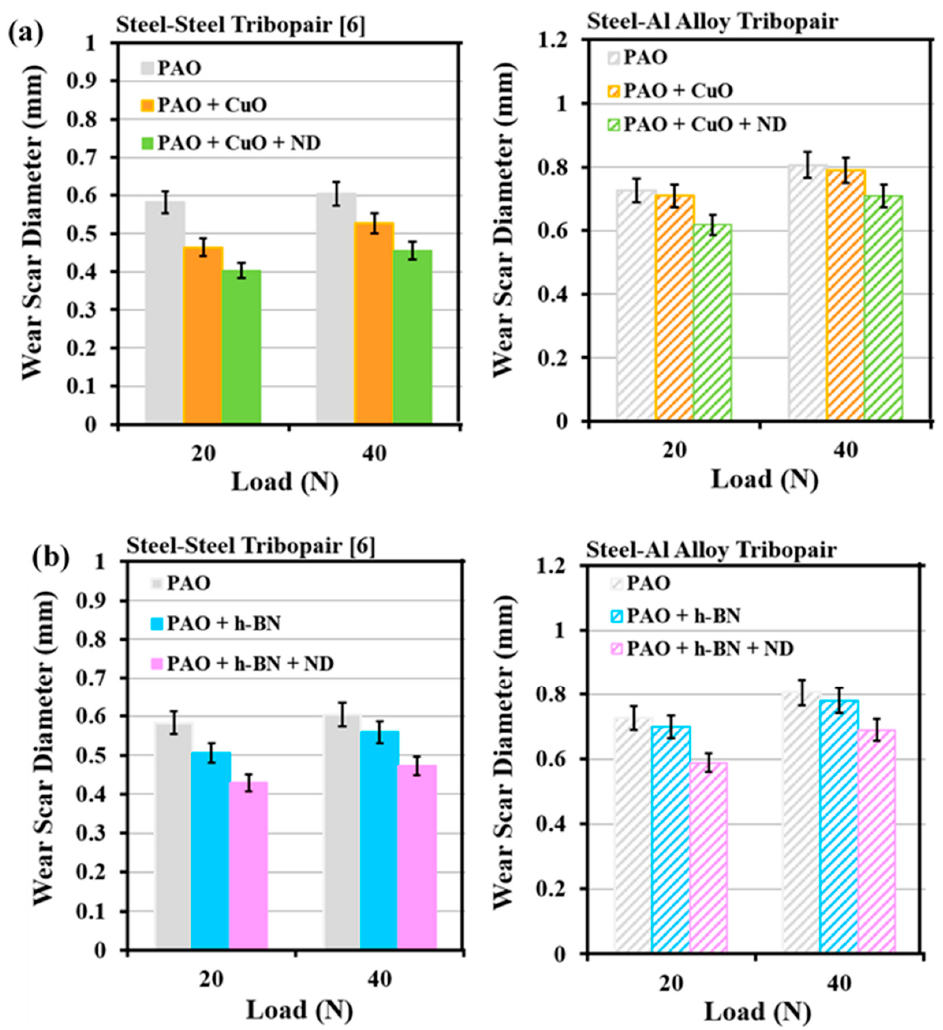
Figure 20. Wear scar diameter (WSD) of the AISI 52100 steel balls slid against En31 steel discs [10] and Al alloy discs under: ( a ) PAO, PAO + CuO primary additive/+ ND secondary additive lubricants and ( b ) PAO, PAO + h-BN primary additive/+ ND secondary additive lubricants.